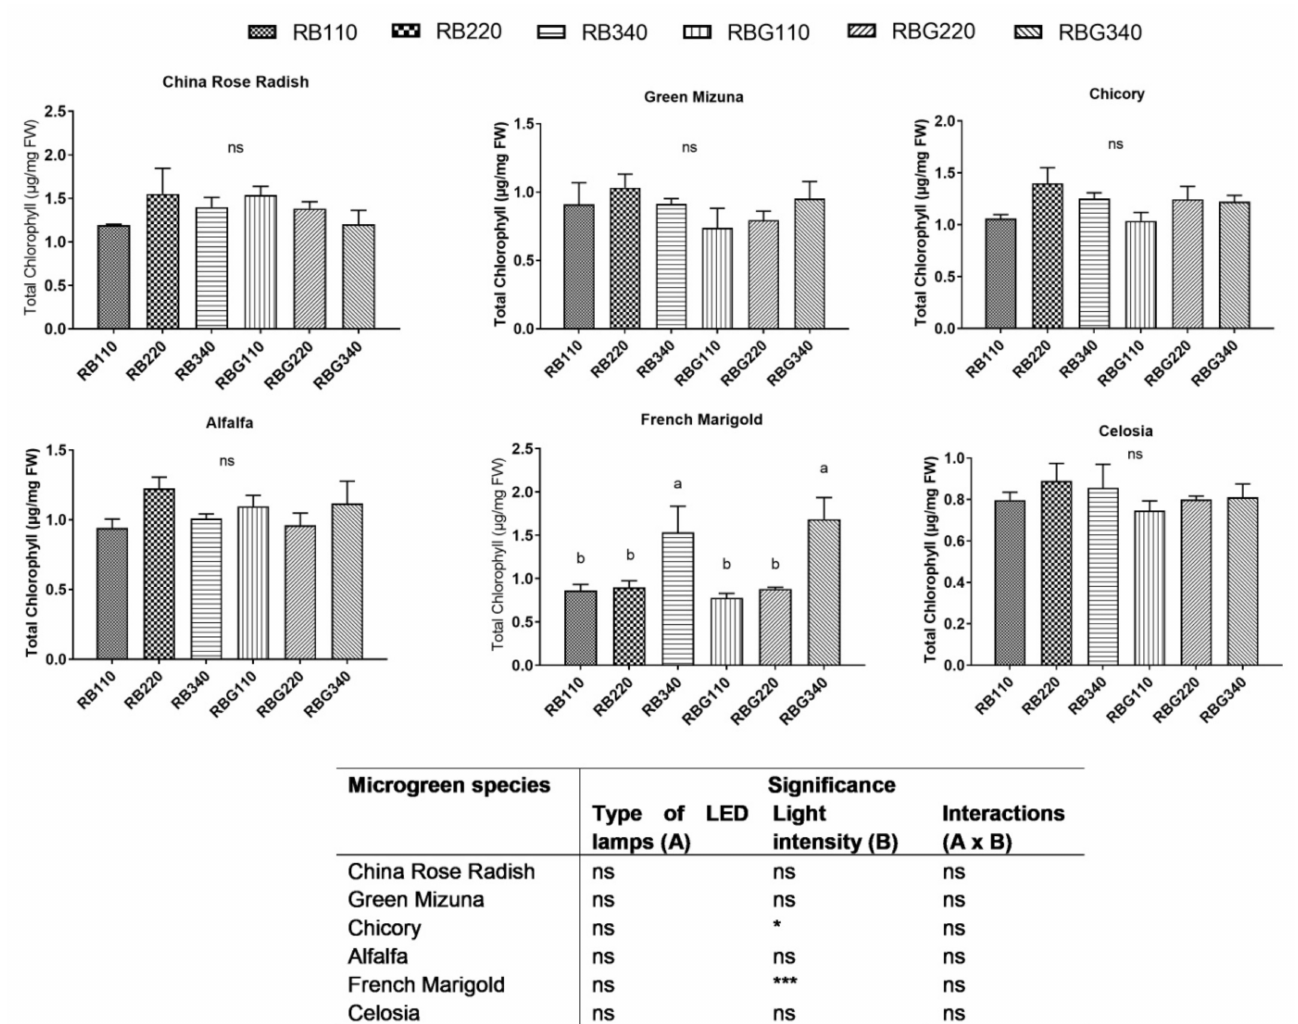
Figure 4. Total chlorophyll content from six microgreen species affected by different light environ- ments. Data are shown as means with at least five independent biological replicates and error bars indicate standard error (SE). Data were subjected to two-way analysis of variance and differences were analyzed by Tukey’s post-hoc. Different letters denote significant differences at p < 0.05. Levels of significance of the parameters assessed for each microgreen species considered where: ns, *, ***, are not significant, significance at p < 0.05, and 0.001 respectively. When there was not significant A × B interaction, the effect of light spectra (A) and light intensity (B) was evaluated separately using one-way ANOVA and t -test, respectively (Supplementary Table S1). Different letters on the histograms within each light spectrum (RB and RGB) indicate significant differences among light intensity (Tukey’s test, p <